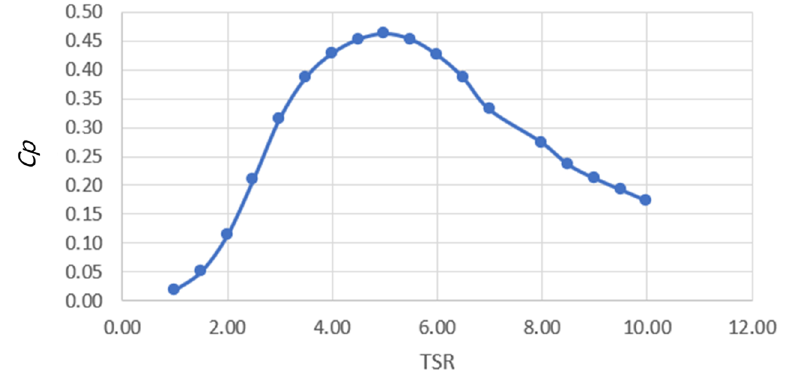
Figure 5. Coefficient of performance ( Cp ) vs. tip speed ratio (TSR) for 3 blades of VAWT.